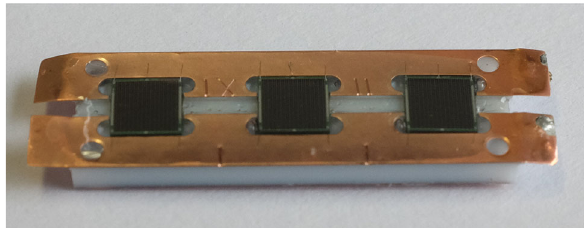
Fig. 16 Custom packaging of three 3 × 3mm 2 SiPMs on a Cuflon ® holder